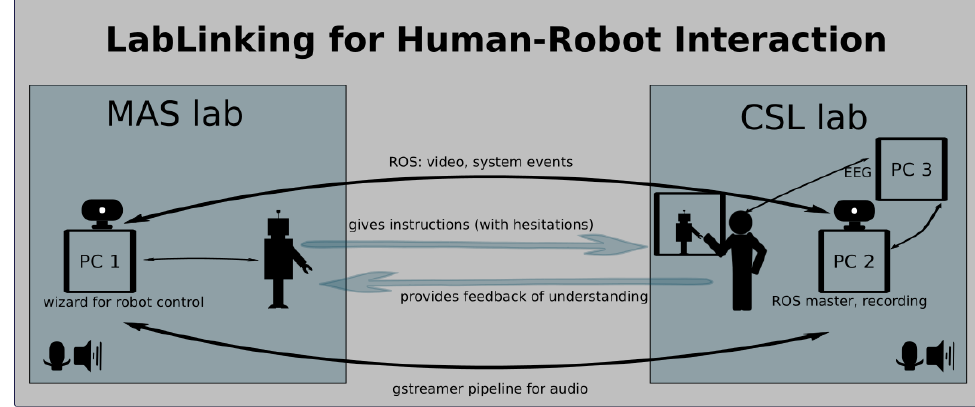
Figure 1. The LabLinking setup for conducting HRI studies between the laboratory of the Medical Assistance System Group (MAS) at Bielefeld University and the Cognitive Systems Lab (CSL) at the University of Bremen: The Pepper robot gives instructions to the human interaction partner, which provides feedback of understanding. The laboratories are connected via a GStreamer pipeline for audio and additional communication via ROS for video and further system